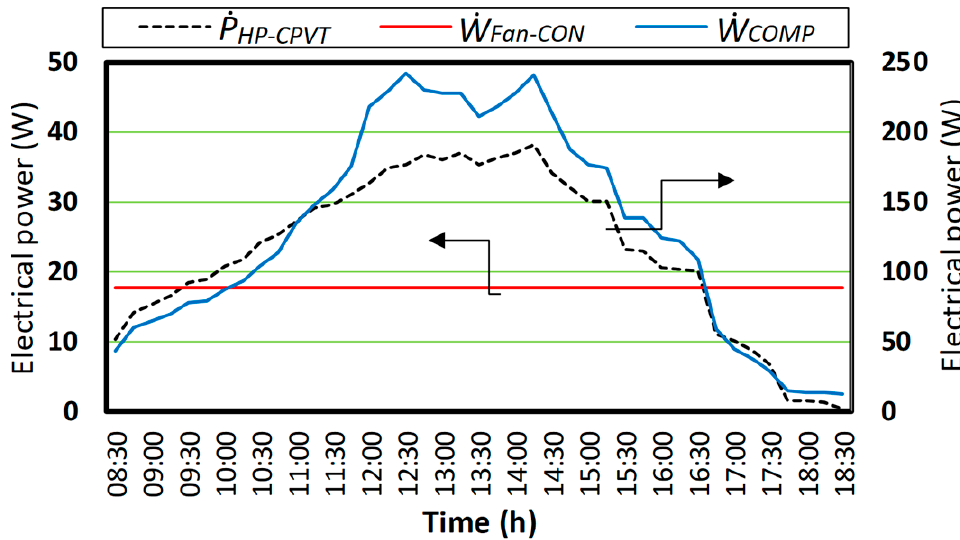
Figure 8. Electric power generated by and electrical efficiency of the bifacial CPVT systems with and without HP.